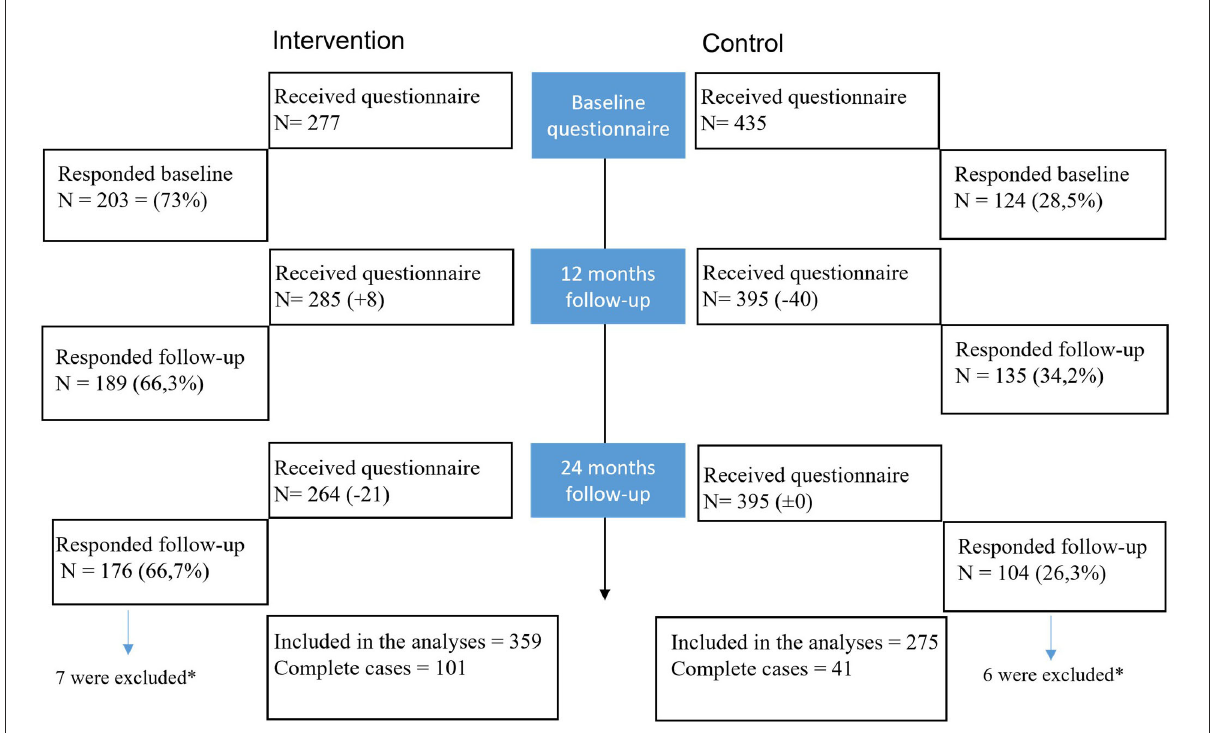
FIGURE2 Flow chart depicting the number of workers receiving and responding to the questionnaires at the different time points. *They were excluded from the analysis as they had only responded to the last follow-up and were hired less than two years